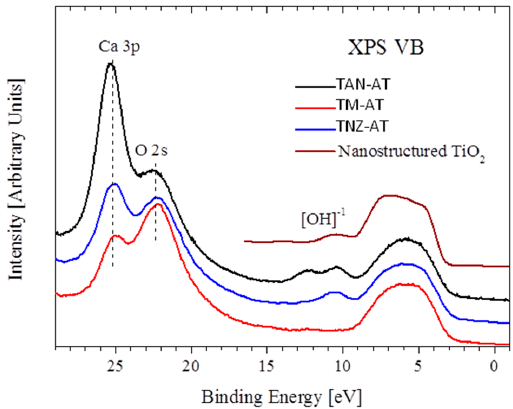
Figure 8. XPS valence bands in treated Ti alloys.